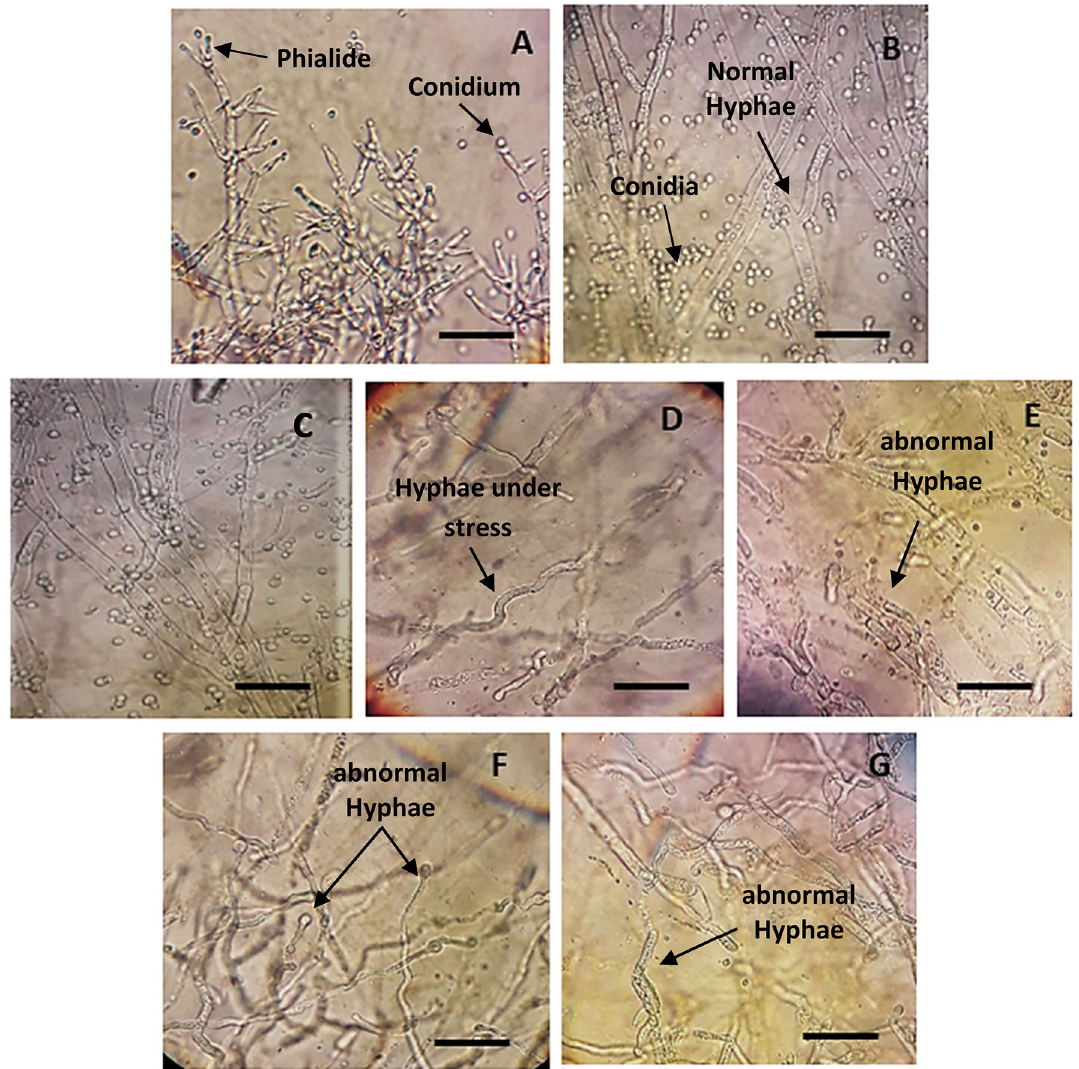
Fig. 2 Effect of different salt concentrations (mM NaCl) on T. viride growth. A and B Normal hypha (Control), C T. viride hypha under (50 mM NaCl) stress, D and E T. viride hypha under (150 mM NaCl) stress, F and G T. viride hypha under (300 mM NaCl) stress. Scale bars: